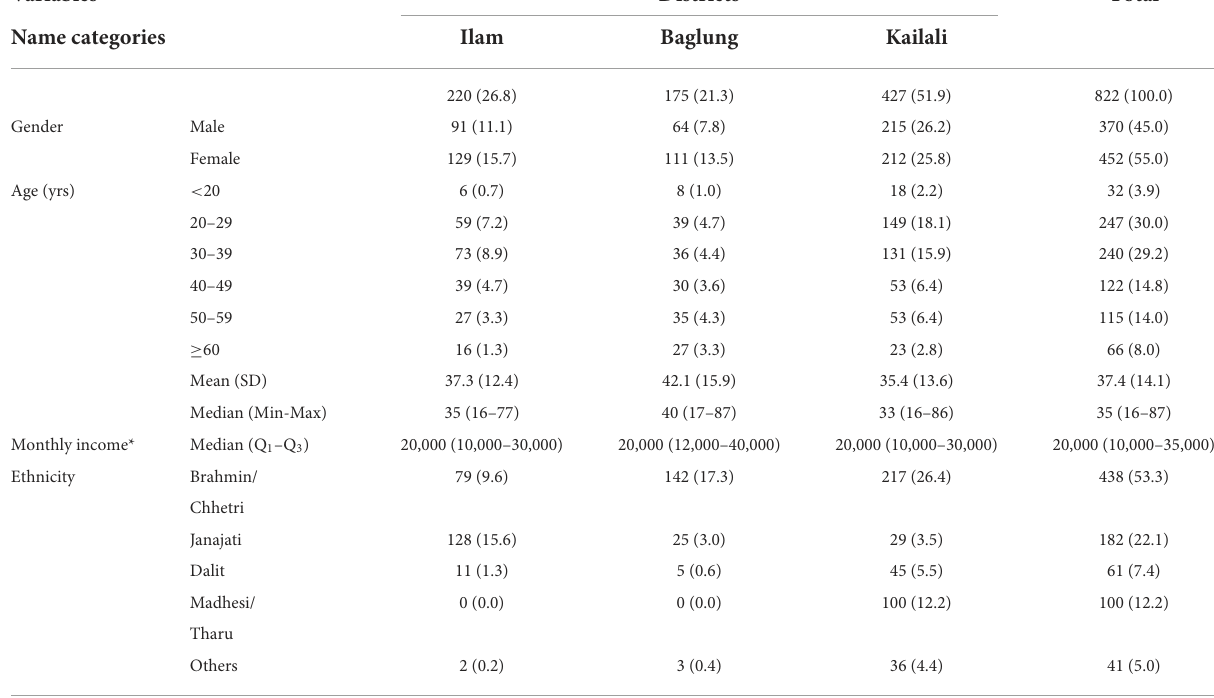
TABLE 1 Socio-economic characteristics of participants ( n =